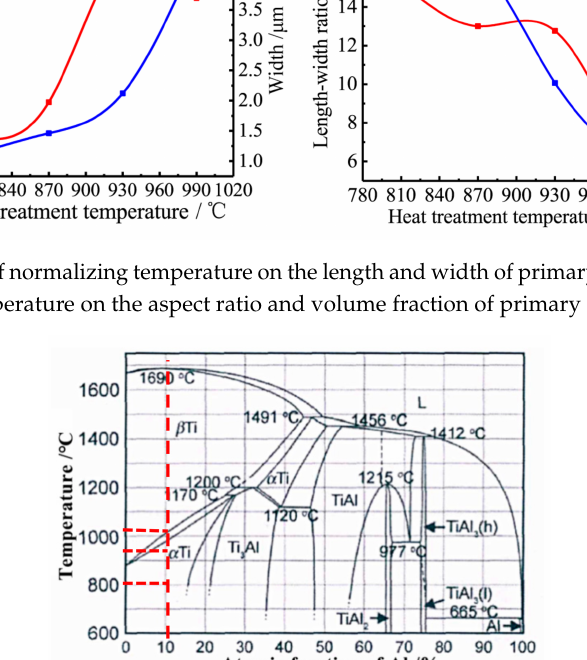
New Fig.5 （ original picture tested with an optical microscope and not in manuscript ） Normalizing microstructure at different temperatures(OM). ( a ) As-deposited, ( b ) 810 °C/2 h/AC, ( c ) 870 °C/2 h/AC, ( d ) 930 °C/2 h/AC, ( e ) 990 °C/2 h/AC.